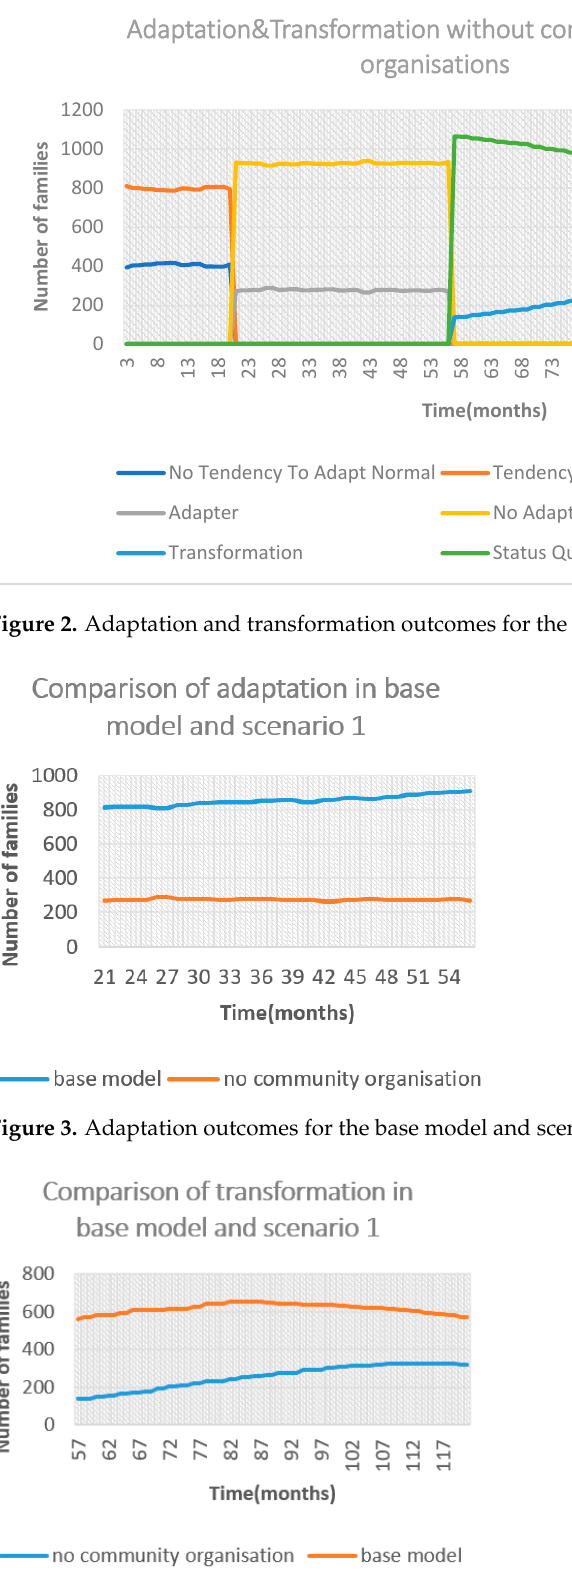
Figure 4. Transformation outcomes for the base model and scenario test.